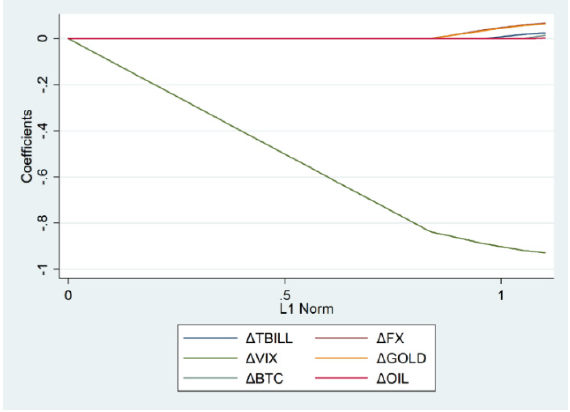
Figure 2. LASSO coefficient paths.